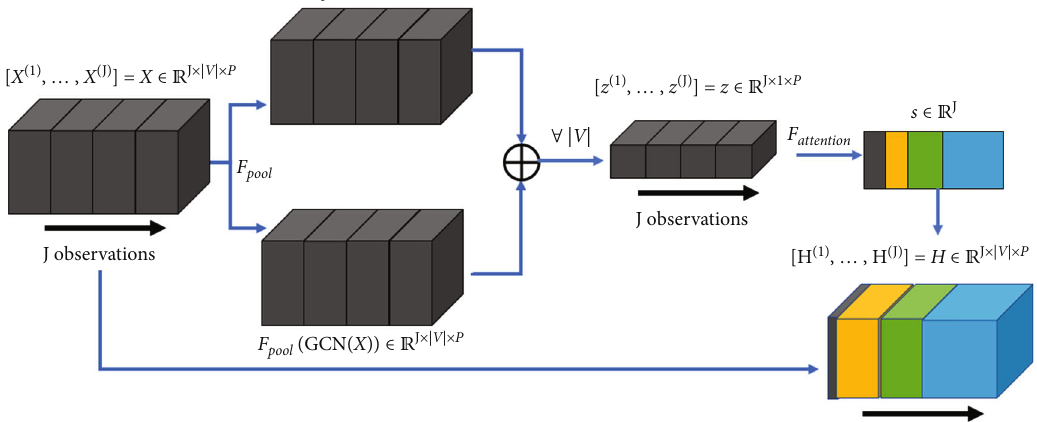
Figure 4: Contextual gating mechanism of the proposed method.